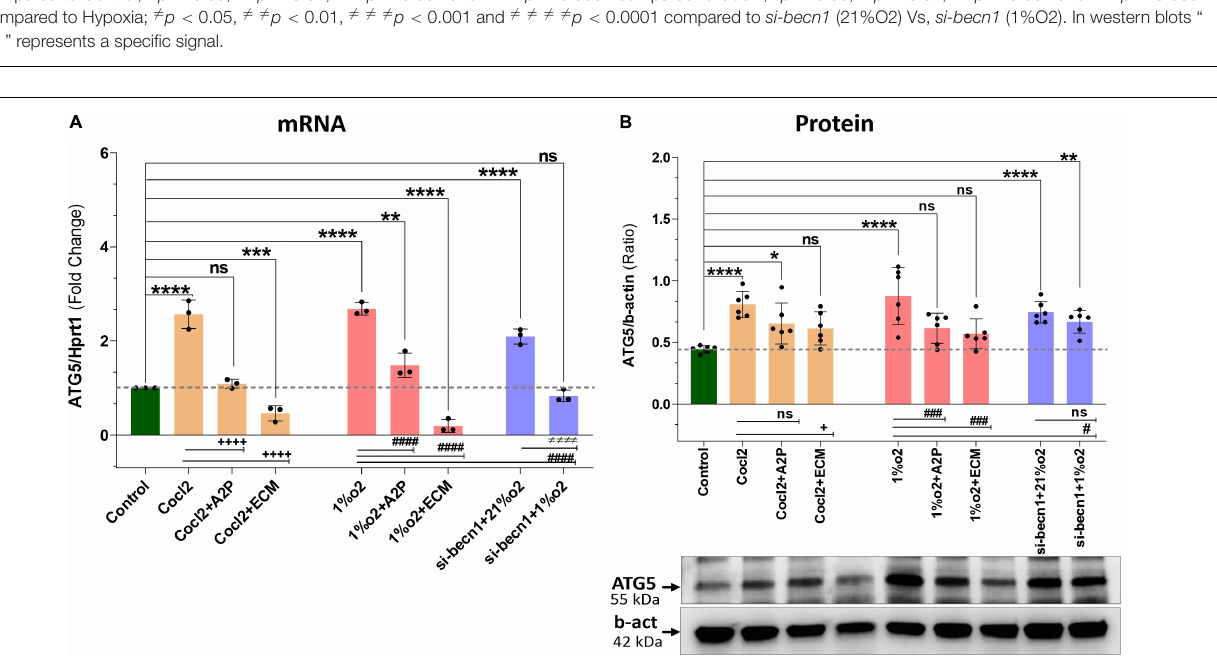
FIGURE 8 | Hypoxia, Cocl2 exposure and Beclin1 inhibition increase the Autophagy protein ATG5 expression levels. (A) ATG5 mRNA expression levels, (B) ATG5 Protein expression levels and representative western blots. ATG5 mRNA levels was increased in h9c2 cells exposed to Cocl2 **** p < 0.0001, and decreased in Cocl2 + ECM (*** p < 0.0004) treated cells. ATG5 mRNA levels increased in Hypoxia (1%O2) cells **** p < 0.0001, 1%O2 + A2P (** p < 0.001) exposed cells, but decreased in 1% O2 + ECM (**** p < 0.0001) exposed cells. Beclin-1 inhibition increased the ATG5 mRNA levels in normoxia (21%O2) **** p < 0.0001 and unchanged in hypoxia (1%O2) exposed cells. In addition compared to Cocl2 cells, Cocl2 + A2P ( ++++ p < 0.0001), Cocl2 + ECM ( ++++ p < 0.0001) cells ATG5 mRNA levels also decreased. Compared to Hypoxia cells, 1%O2 + A2P ( #### p < 0.0001), 1%O2 + ECM ( #### p < 0.0001) and in beclin-1 inhibition cells grown under Hypoxia ( #### p < 0.0001) expressed significantly decreased ATG5 mRNA levels. Compared to control cells, ATG5 protein expression levels were increased in Cocl2 (**** p < 0.0001), Hypoxia (**** p < 0.0001) exposed cells. Beclin-1 inhibition cells exposed to normoxia (21%O2) **** p < 0.0001 and Hypoxia (** p < 0.005) showed increased ATG5 protein. In addition compared to Hypoxia cells, 1%O2 + ECM ( ### p < 0.001), 1%O2 + A2P ( ### p < 0.0006) and Beclin-1 inhibition cells ( # p < 0.02) express decreased ATG5 protein and no significant changes in ATG5 protein expression level. Data represents, n = 3 (mRNA) and n = 6 (Protein) independent samples/group. Bars are mean ± S.D. Symbols * , + , # and (cid:54)= denotes significant, “ns” represents not significant by two-way ANOVA- multiple comparisons test. P-values are ns p > 0.05, * p < 0.05, ** p < 0.01, *** p < 0.001 and **** p < 0.0001 compared to Control; + p < 0.05, ++ p < 0.01, +++ p < 0.001 and ++++ p < 0.0001 compared to Cocl2; # p < 0.05, ## p < 0.01, ### p < 0.001 and #### p < 0.0001 compared to Hypoxia; (cid:54)= p < 0.05, (cid:54)= (cid:54)= p < 0.01, (cid:54)= (cid:54)= (cid:54)= p < 0.001 and (cid:54)= (cid:54)= (cid:54)= (cid:54)= p < 0.0001 compared to si-becn1 (21%O2) Vs, si-becn1 (1%O2). In western blots “ → ” represents a specific